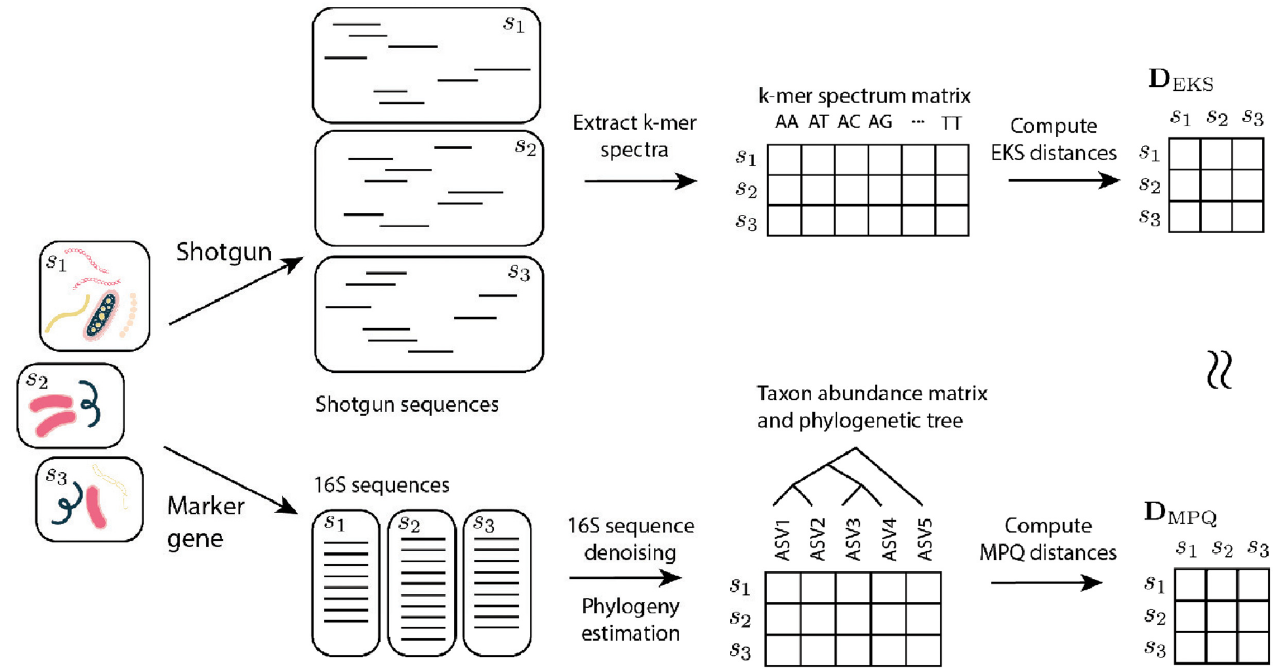
Fig 1. Schematic of the process for computing MPQ distances and EKS distances. We show that there is a close relationship between the MPQ distances, which are designed for marker gene studies, and the EKS distances, which are designed for shotgun metagenome sequencing studies.